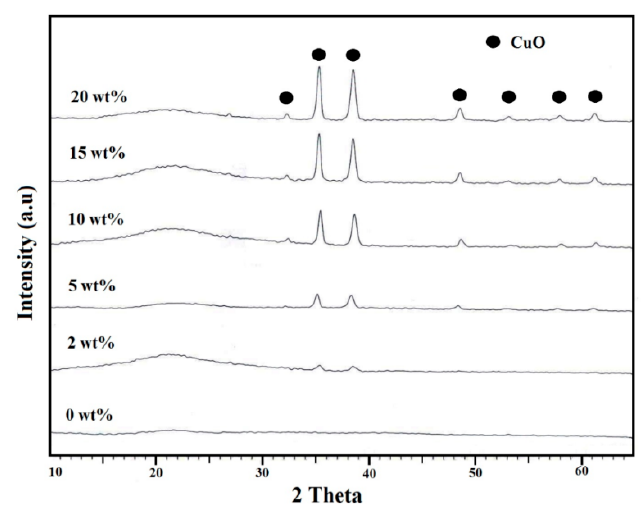
Figure 1. XRD patterns of various Cu/SiO 2 catalysts. Figure 2. XRD patterns of series of reduced Cu/SiO 2 catalysts.